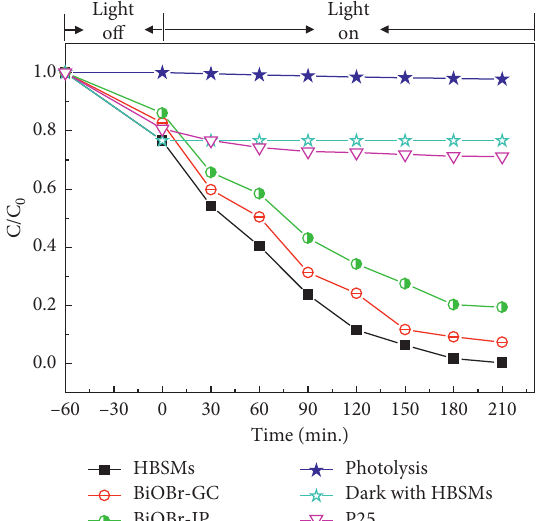
Figure 8: Comparable plots of the MO degradation efficiencies over the as-prepared BiOBr samples and commercial P25, direct photocatalysis of the MO under visible light irradiation, and the removal of the MO in dark with the HBSMs. C and C 0 indicate the residual and initial concentrations of the MO, respectively.